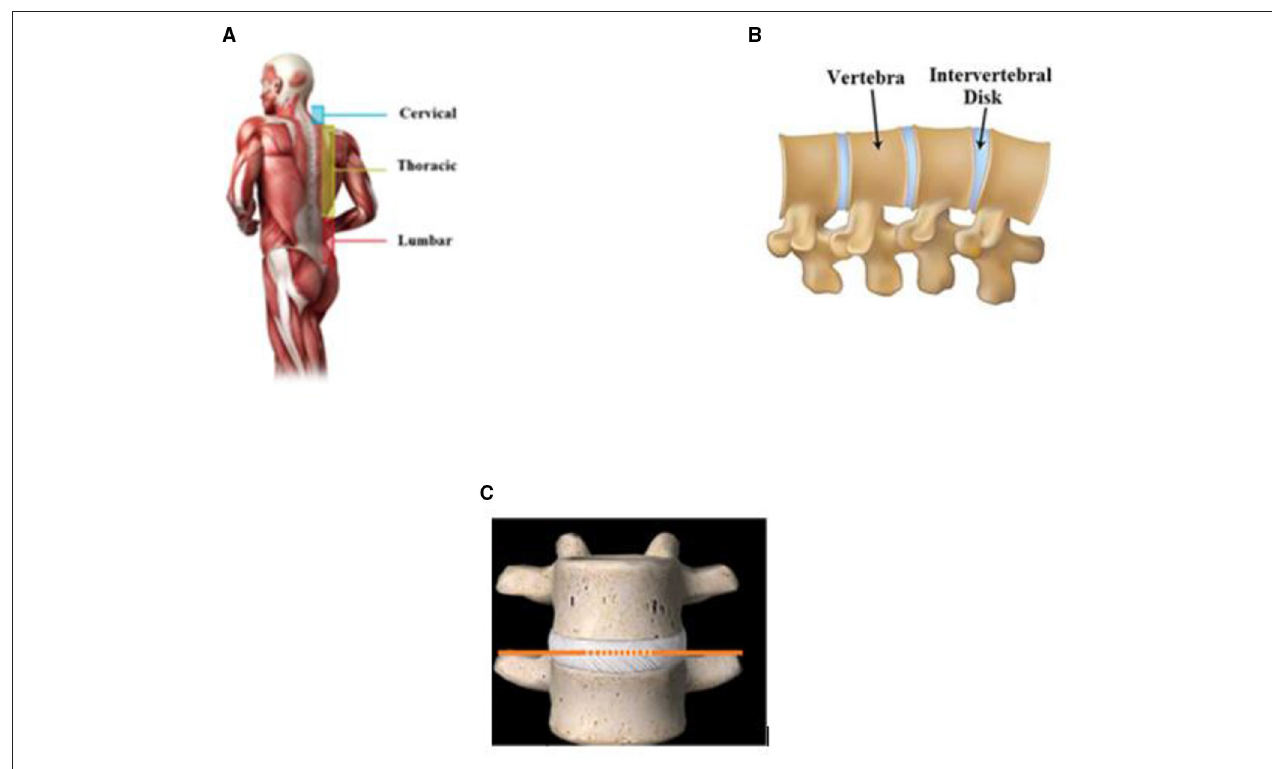
FIGURE 9 | Spinal cord parts of human with integrated FBG sensor (A) (57). Intervertebral disk in the spinal cord (B) (52). FBG sensor integrated with intervertebral disk (C) (